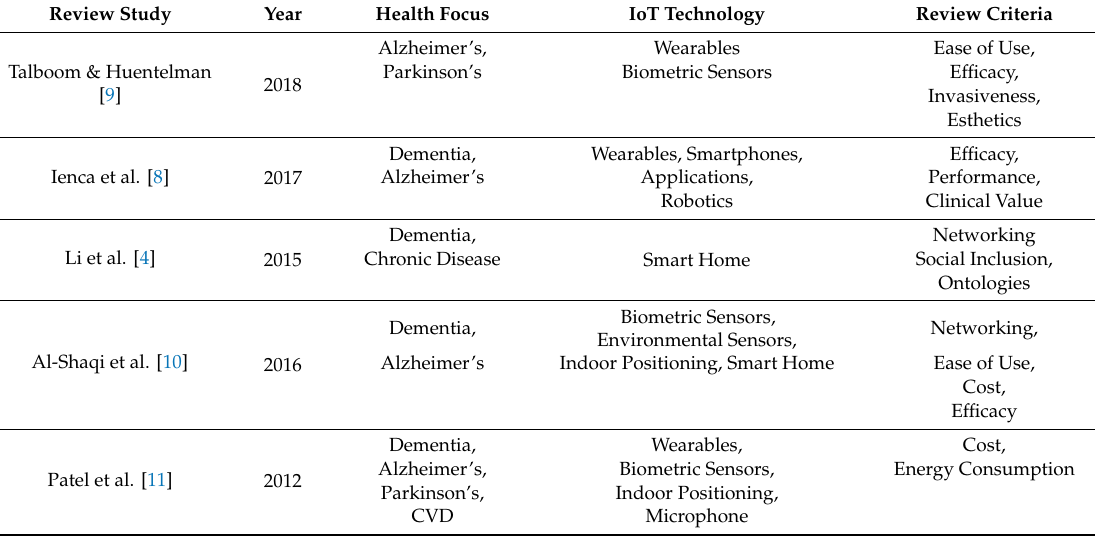
Table 1. Review studies and their aspects: health focus, Internet of Things (IoT) technology, and review